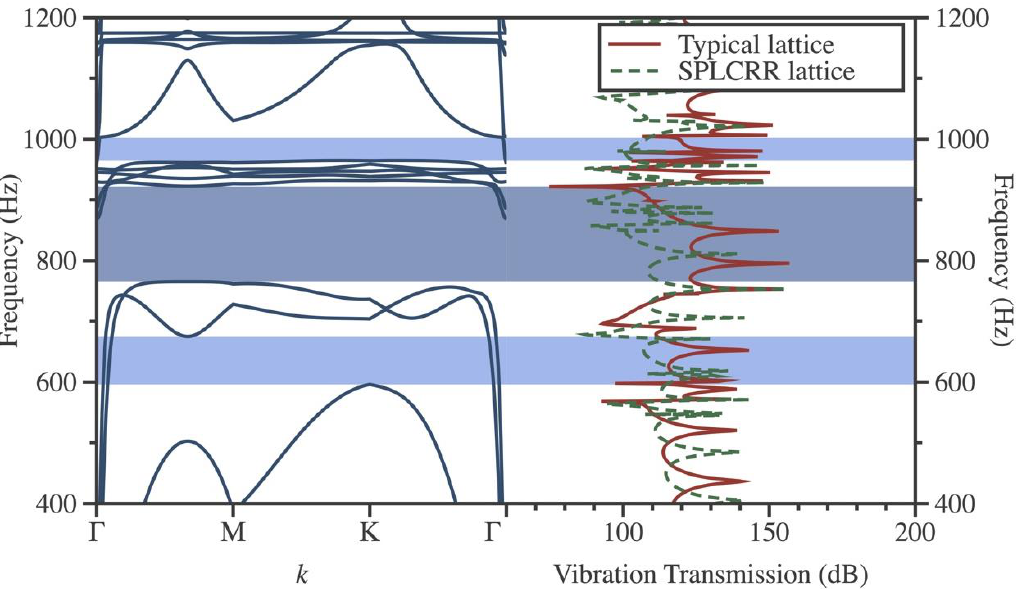
Figure 4. Vibration transmission spectra of non-dissipative typical and SPLCRR structures.